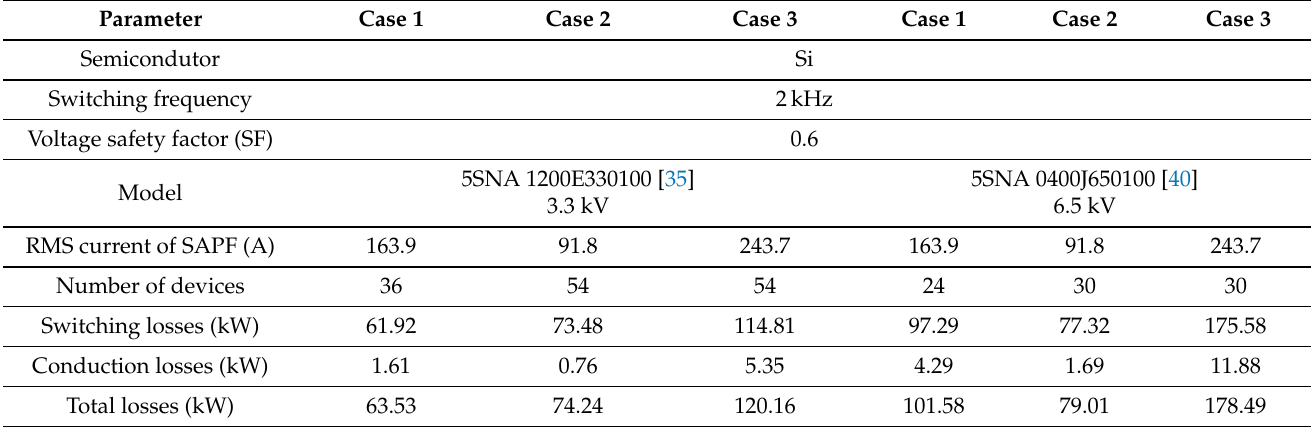
Table 4. Comparison results for the Si-IGBT SAPF.